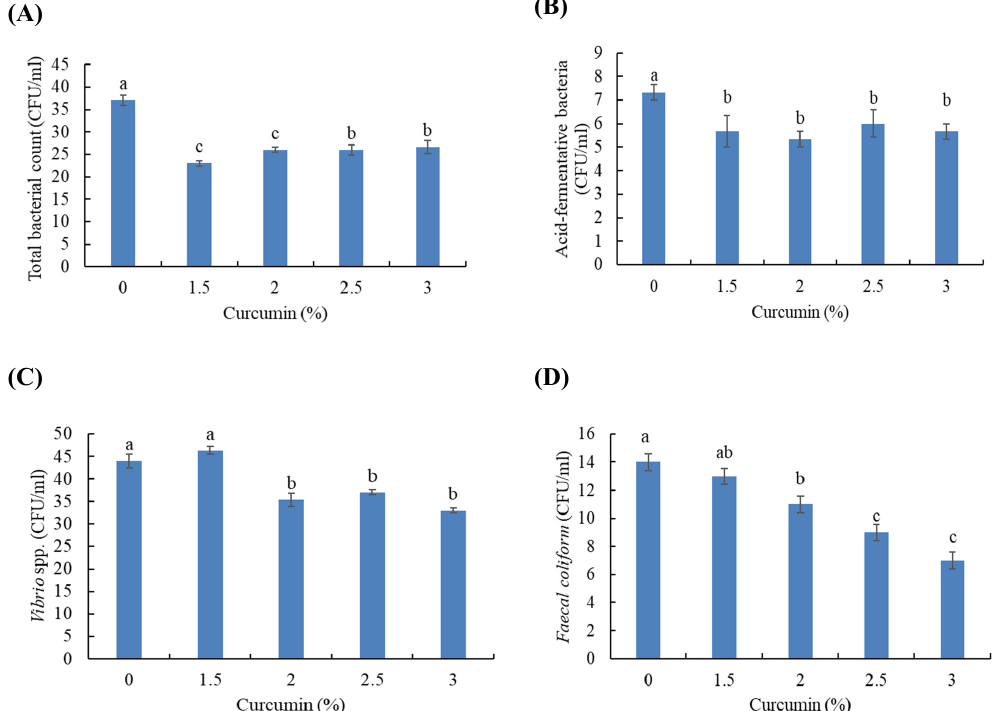
Figure 1. Intestinal microbial population in Gilthead seabream fed varying levels of dietary curcumin for 150 days: ( A ) total antibacterial count, ( B ) acid-fermentative bacteria, ( C ) Vibrio spp., and ( D ) Faecal coliform . A colony-forming unit (CFU) was used to check the count of bacteria per ml. Bars with different letters are significantly different ( p < 0.05) ( n = 3).